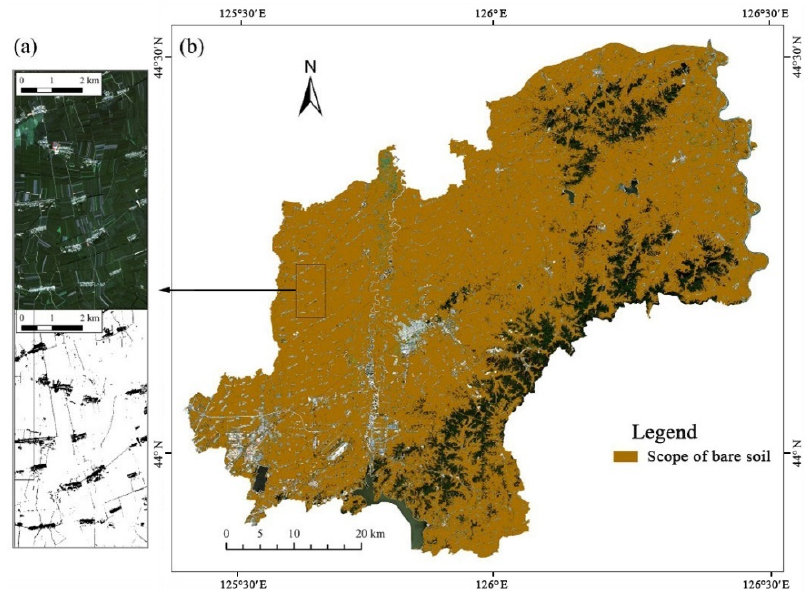
Figure 2. Spatial distribution of bare cultivated land in the study area. ( a ) map is the effect diagram of bare cultivated land identification in part of ( b ) map.